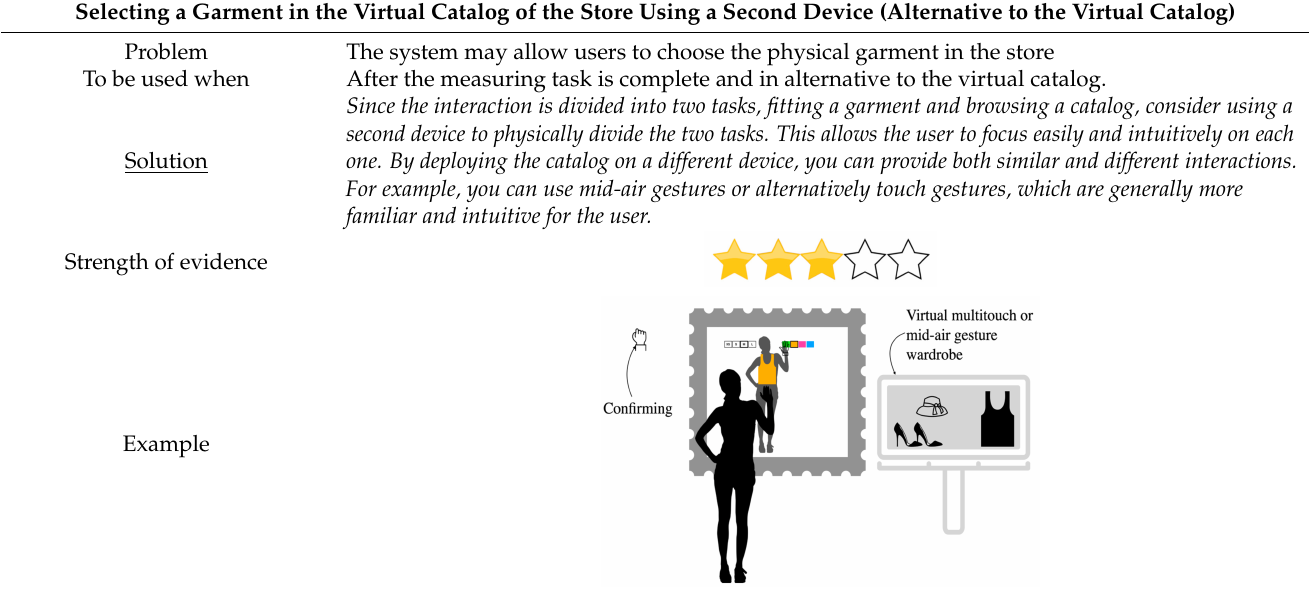
Table 8. Selecting a garment in the virtual catalog of the store using a second